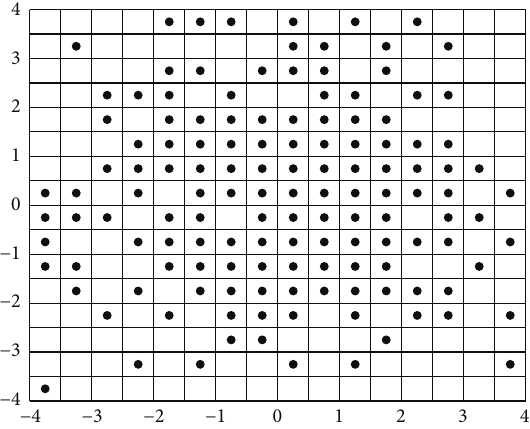
Figure 9: Array configuration for 136 elements.